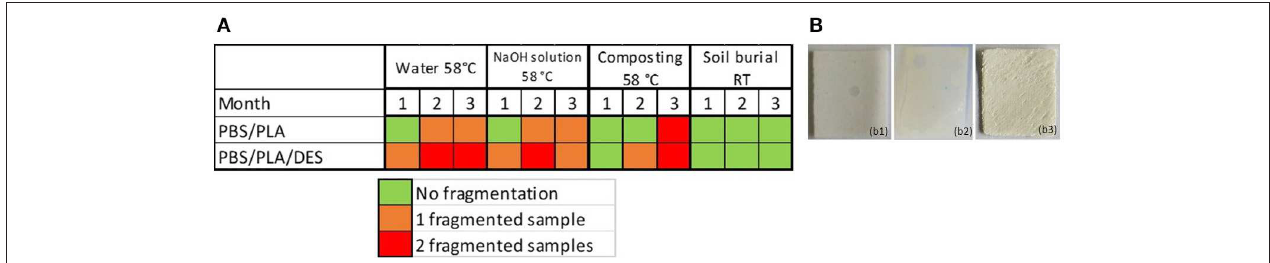
FIGURE 5 | (A) Fragmentation observed during aging experiments after various exposure times: 1, 2, and 3 months. (B) Photographies of poly(butylene succinate) (PBS)/poly(lactic acid) (PLA) blend (60:40) wt phr after 1 (b1) and 3 (b2) months of exposure and PBS/PLA/deep eutectic solvents (DES) (60:40:1) wt phr (b3) after 3 months of exposure in NaOH solution at 58 ◦ C.